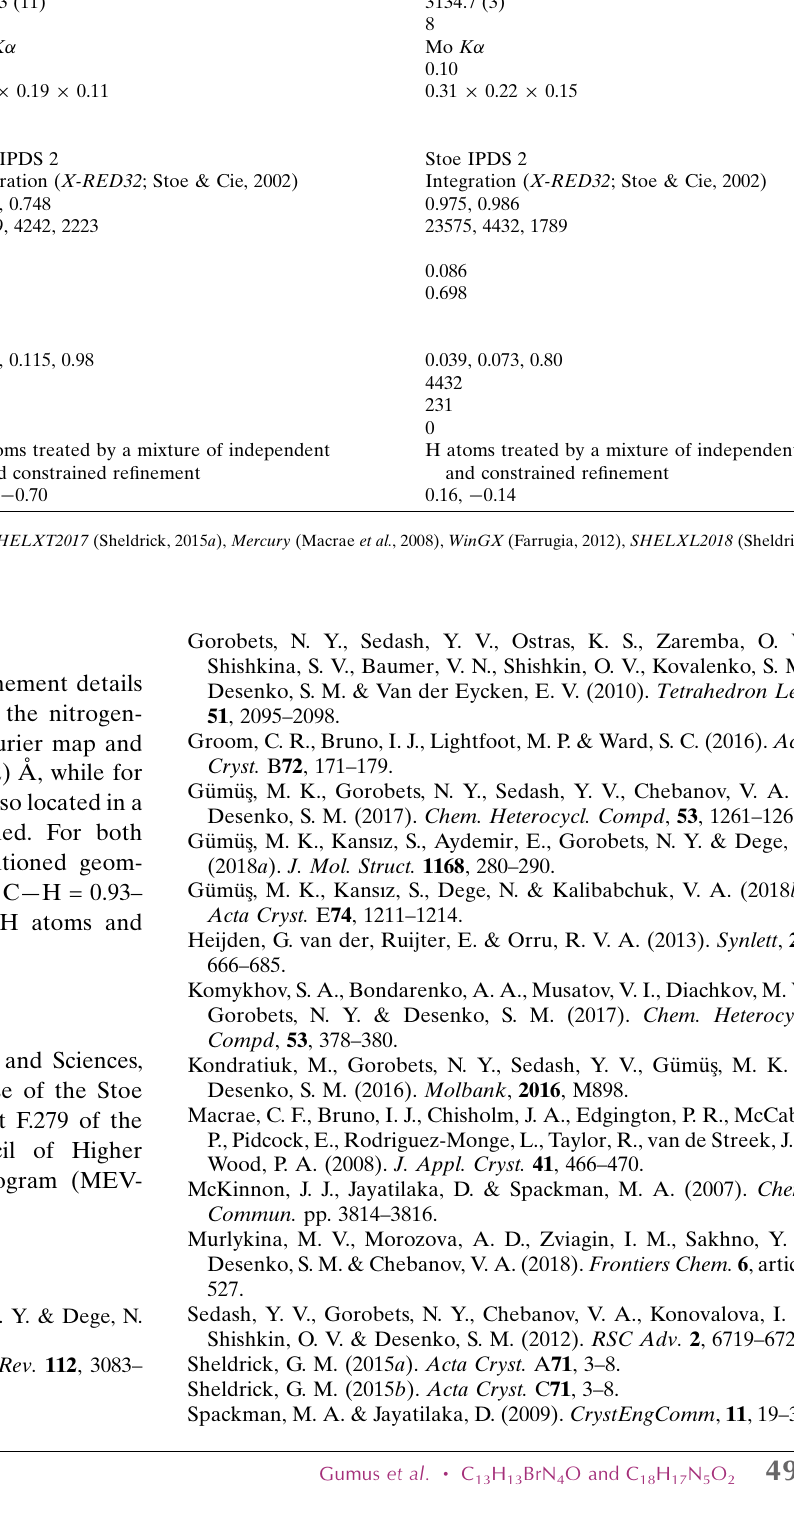
Crystal data Chemical